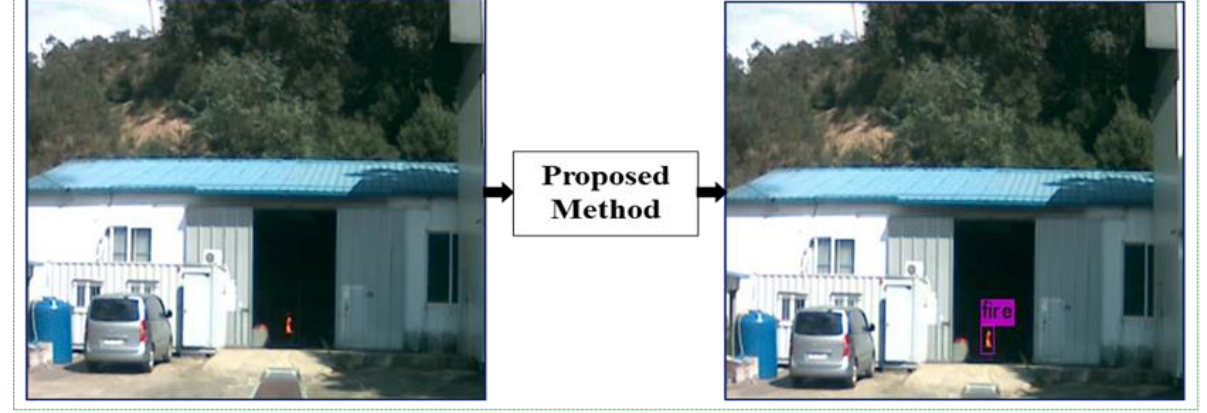
Figure 4. Fire detection process of the proposed method.